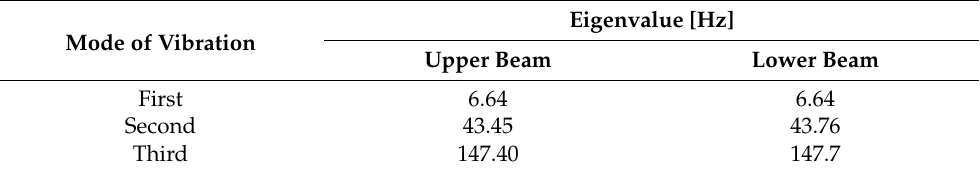
Figure 7. The numerical model of the smart intact structure with both piezo-composites attached to the host structure: (A) fixed support, (B) magnetic force—upper magnet, (C) magnetic force—lower magnet. Table 2. Values of natural frequencies of the intact structure and damage Table 1. Material properties of homogenized MFC layer of MFC8514 P2 [4].